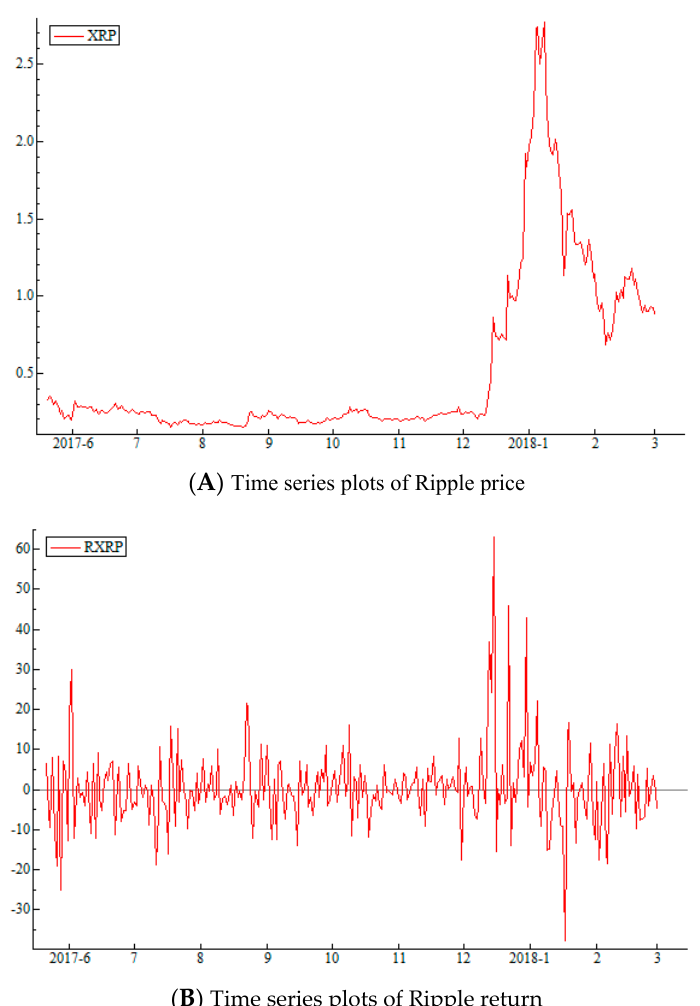
Figure 3. Time Series Plots of Ripple Price and Return. ( A ) Presents the plot historical plot of daily closing prices for Ripple between May 20, 2017 and February 28, 2018; ( B ) presents the daily returns for Ripple for the same time period. The data is obtained from Bitfinex.